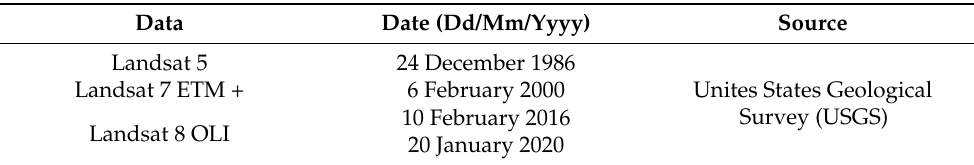
Table 1. Summary of the acquired multispectral Landsat scenes.